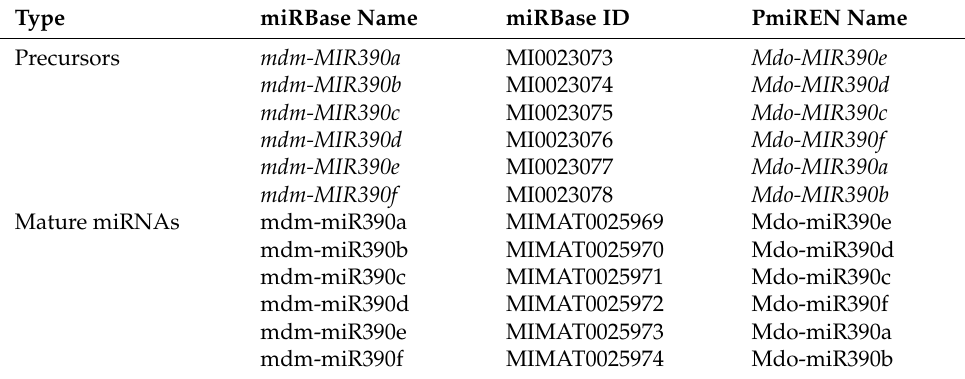
Table 1. Apple MIR390 and miR390